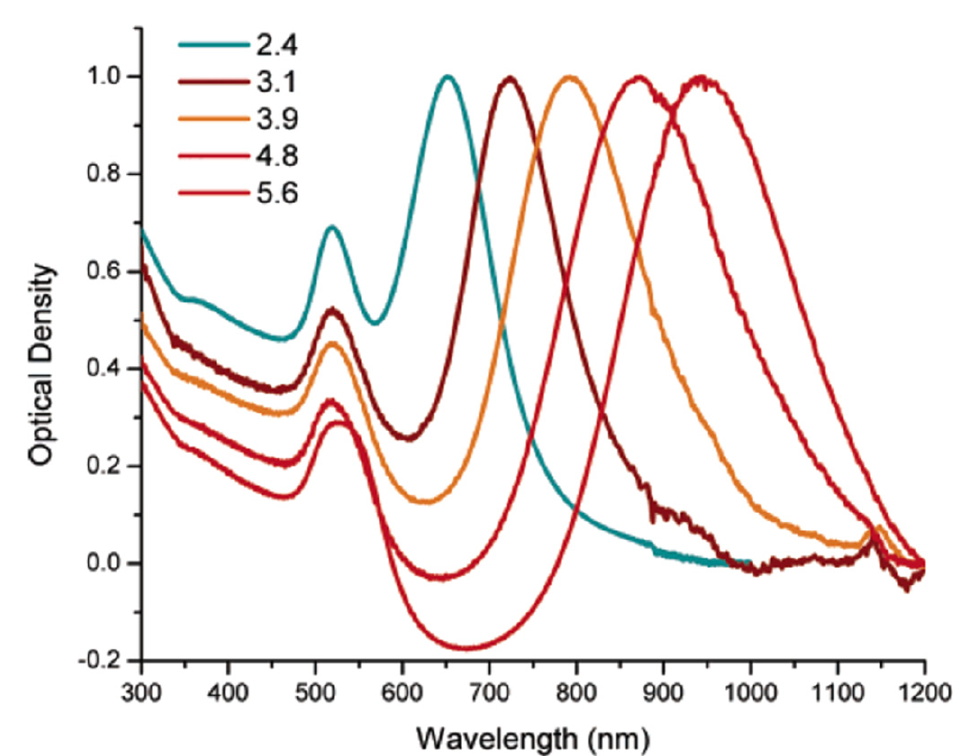
Figure 8. Surface plasmon absorption spectra for different nanorods’ aspect ratios. Reprinted (adapted) with permission from [99], Copyright 2006 American Chemical Society.